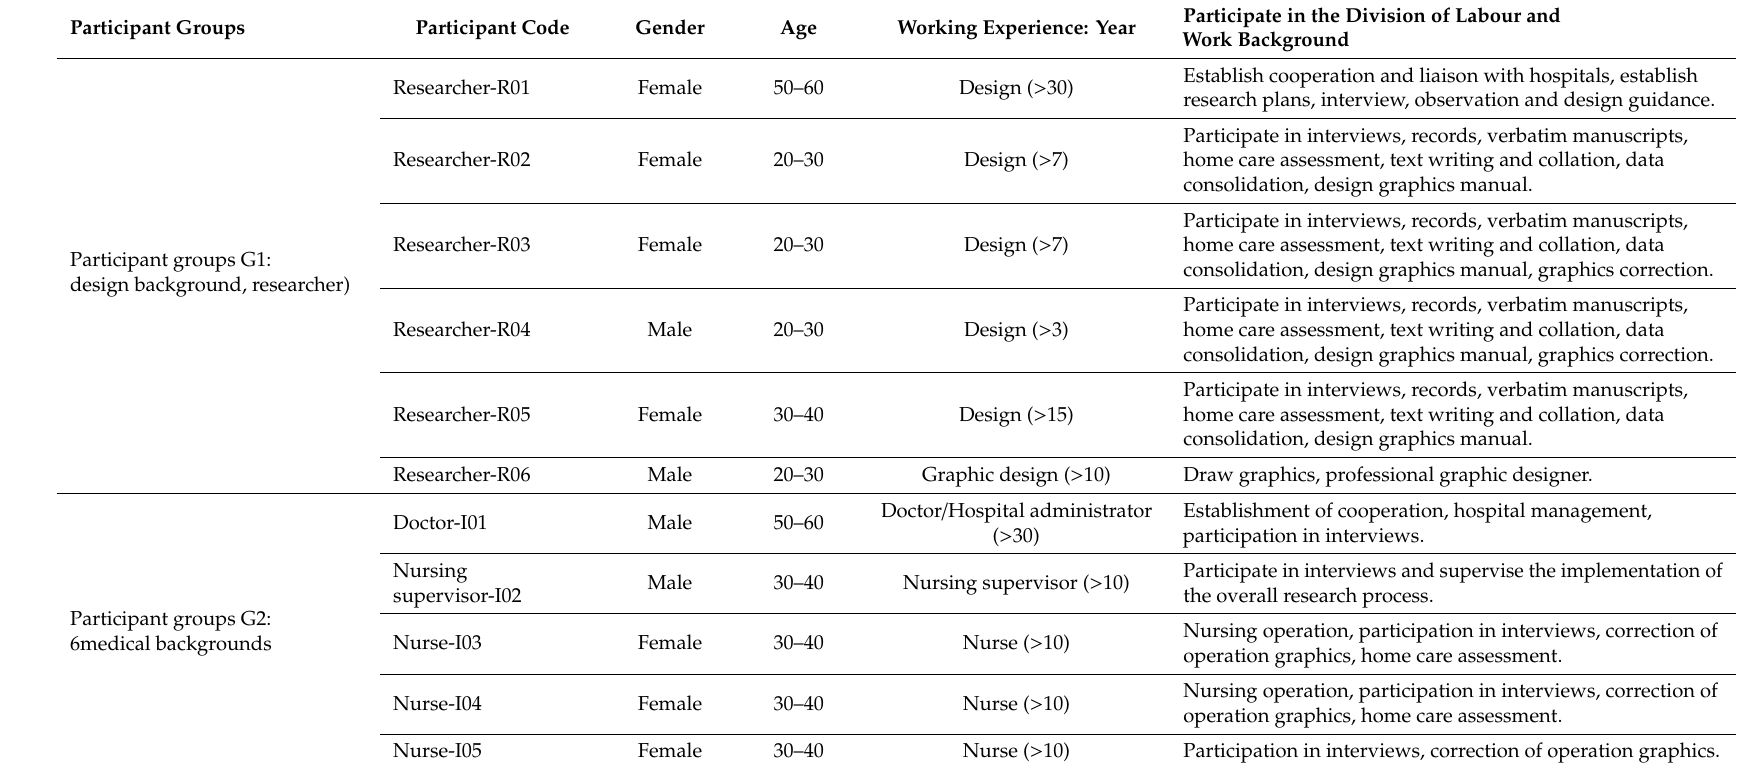
Table 1. Interview participants’ background and research